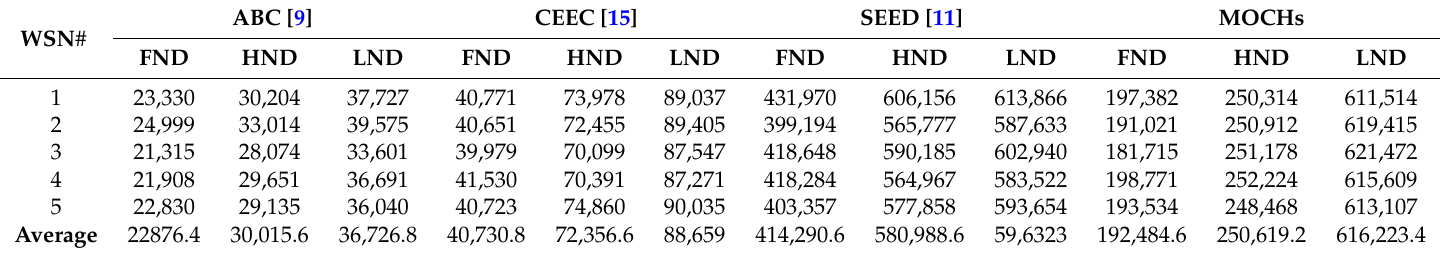
Table 6. Total number of data packets received at the BS over simulations of five WSNs (with 200 nodes).